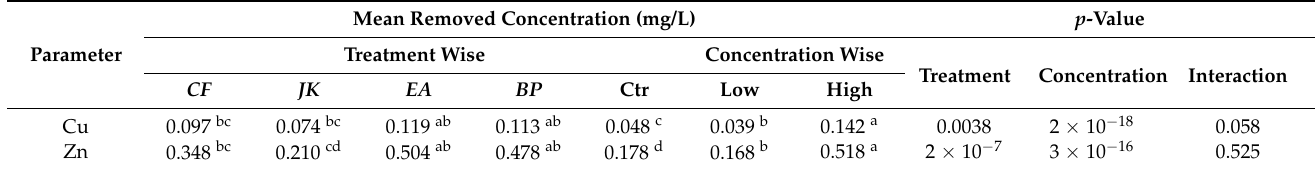
Table 2. Statistical comparison of mean removal of Cu and Zn by Scheirer–Ray–Hare test and Kruskal-Wallis post-hoc